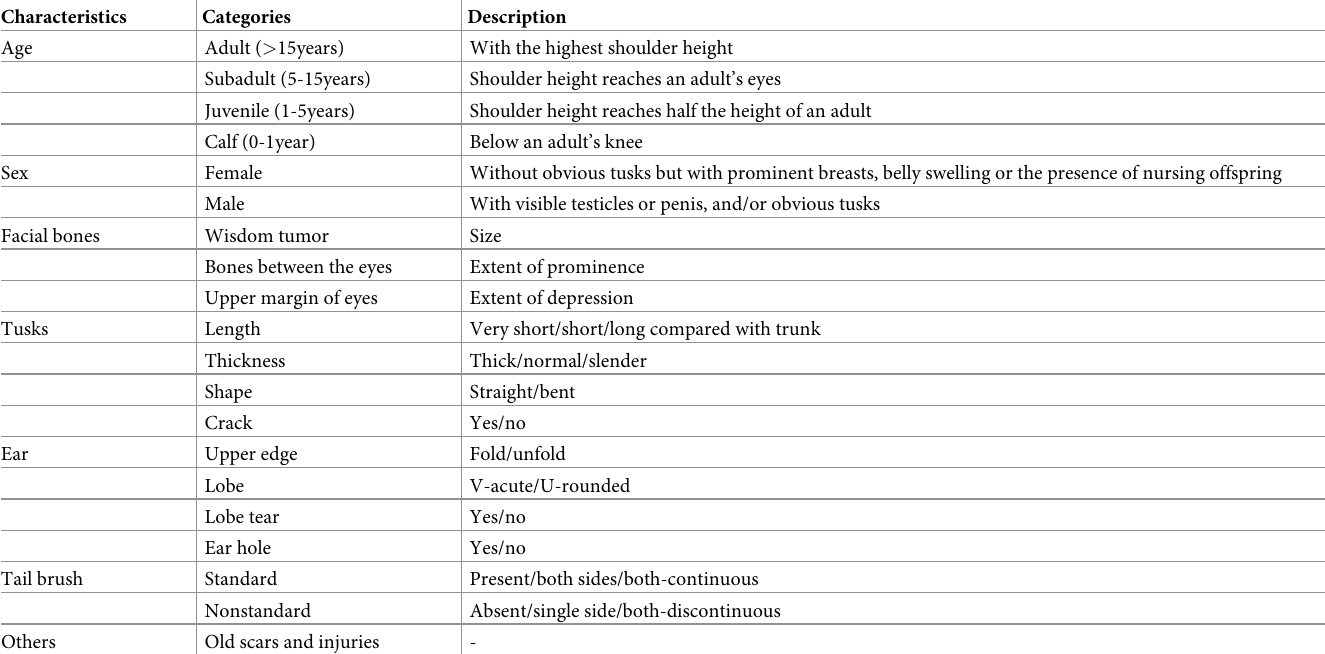
Table 1. Morphological characteristics used for individual identification of elephants photographed in NNNR, between February and May 2018.